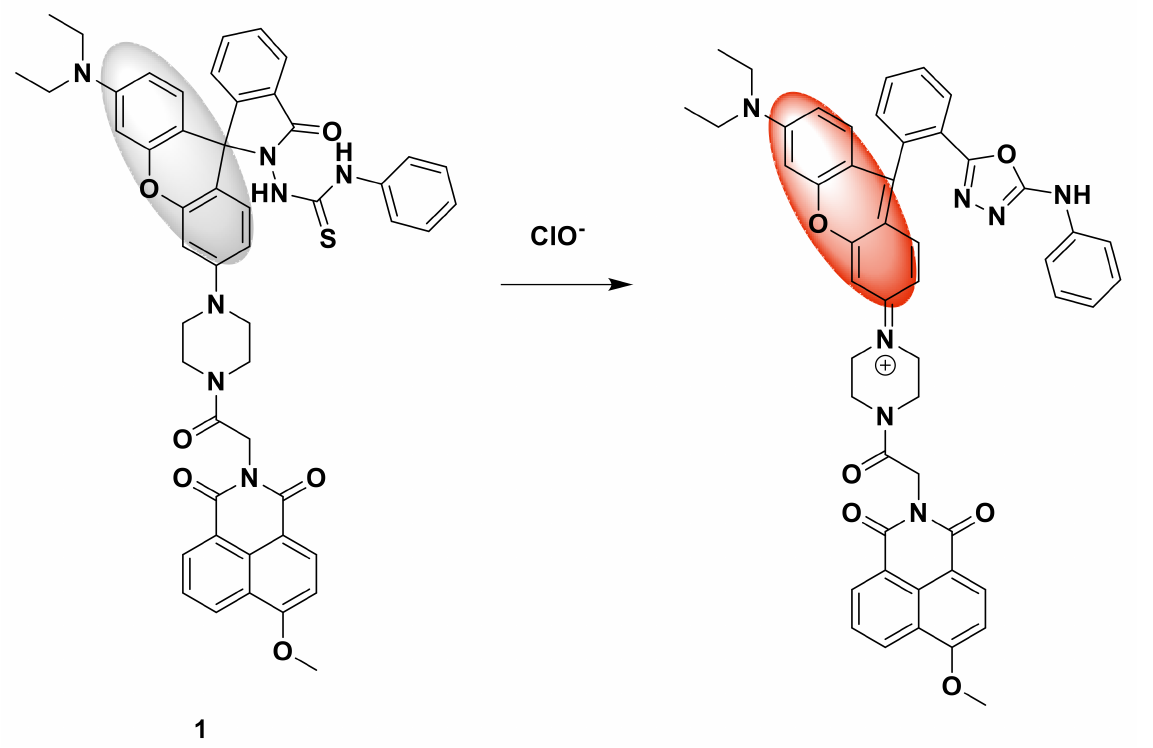
Figure 1. The reaction of probe 1 and ClO −